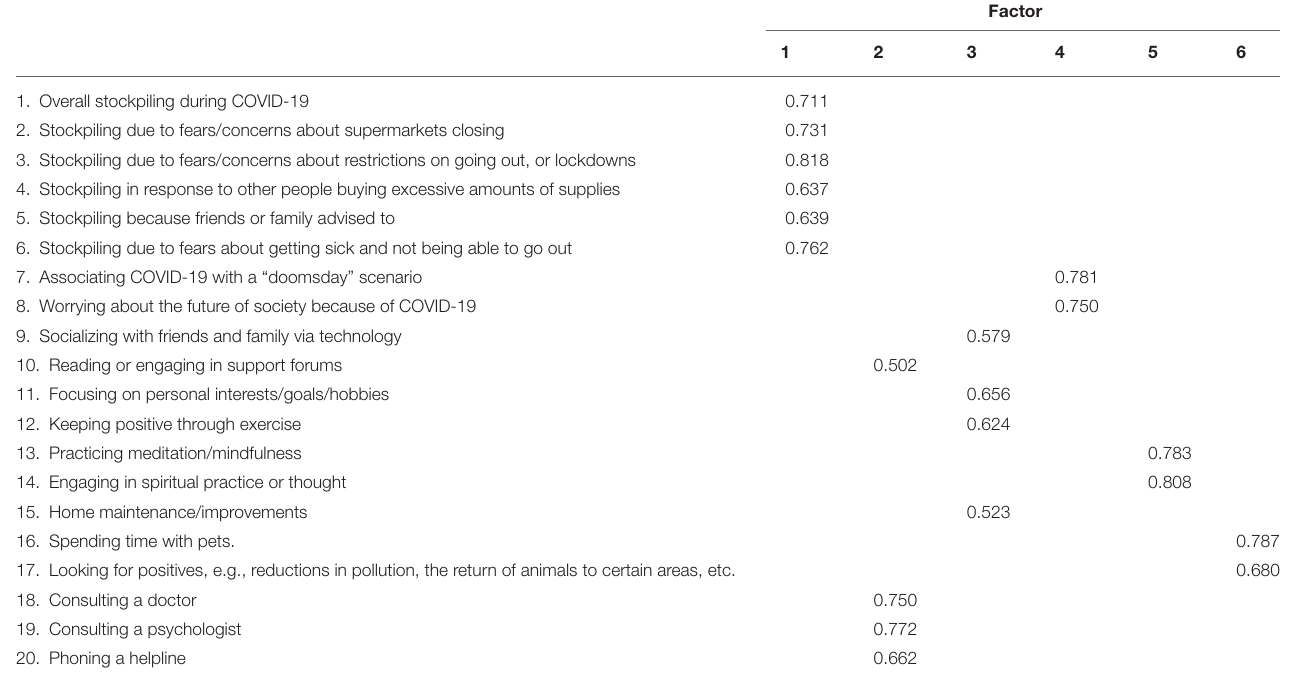
TABLE 3 | Component loading values of the six-factor structure of the Prepping and Coping during a Pandemic